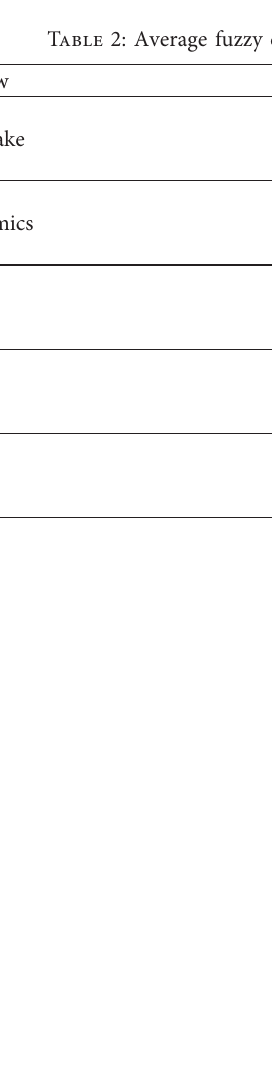
Figure 1: Average fuzzy data transmission time of different algorithms under various scientific